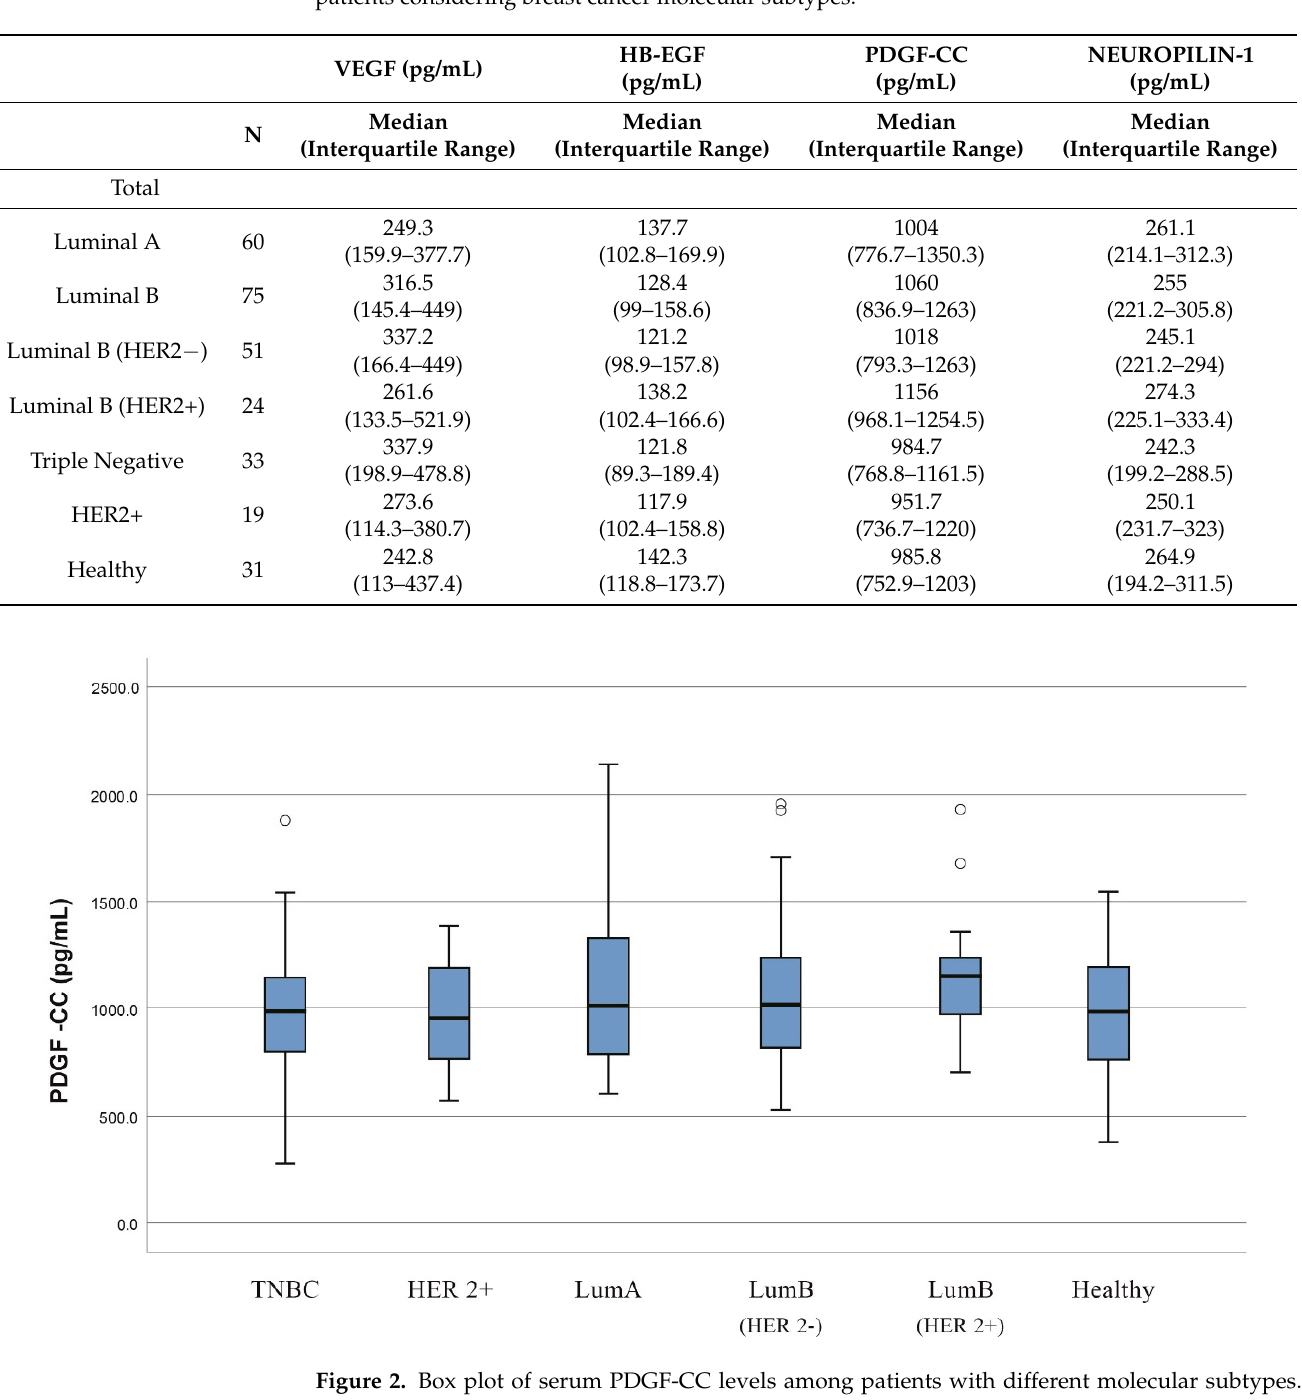
Table 2. Median concentrations of VEGF, HB-EGF, PDGF-CC and NRP-1 in the serum of the examined patients considering breast cancer molecular subtypes.